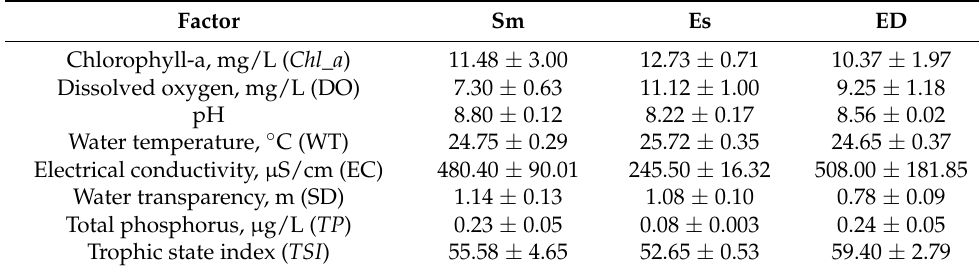
Table 3. Factors (mean ± SD) measured for zooplankton community 2.